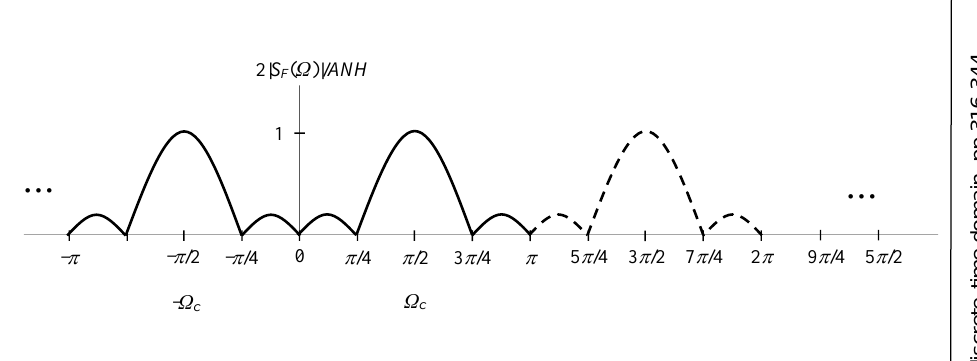
Figure 17 − Magnitude spectral density of the modulated filtered pulse Рис. 17 – Спектральная плотность модулированного